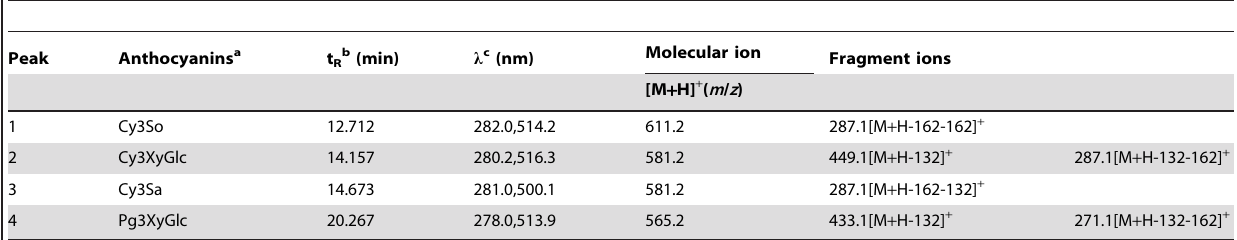
Table 2. Chromatographic and spectral data of anthocyanins detected in 44 Lycoris longituba varieties.